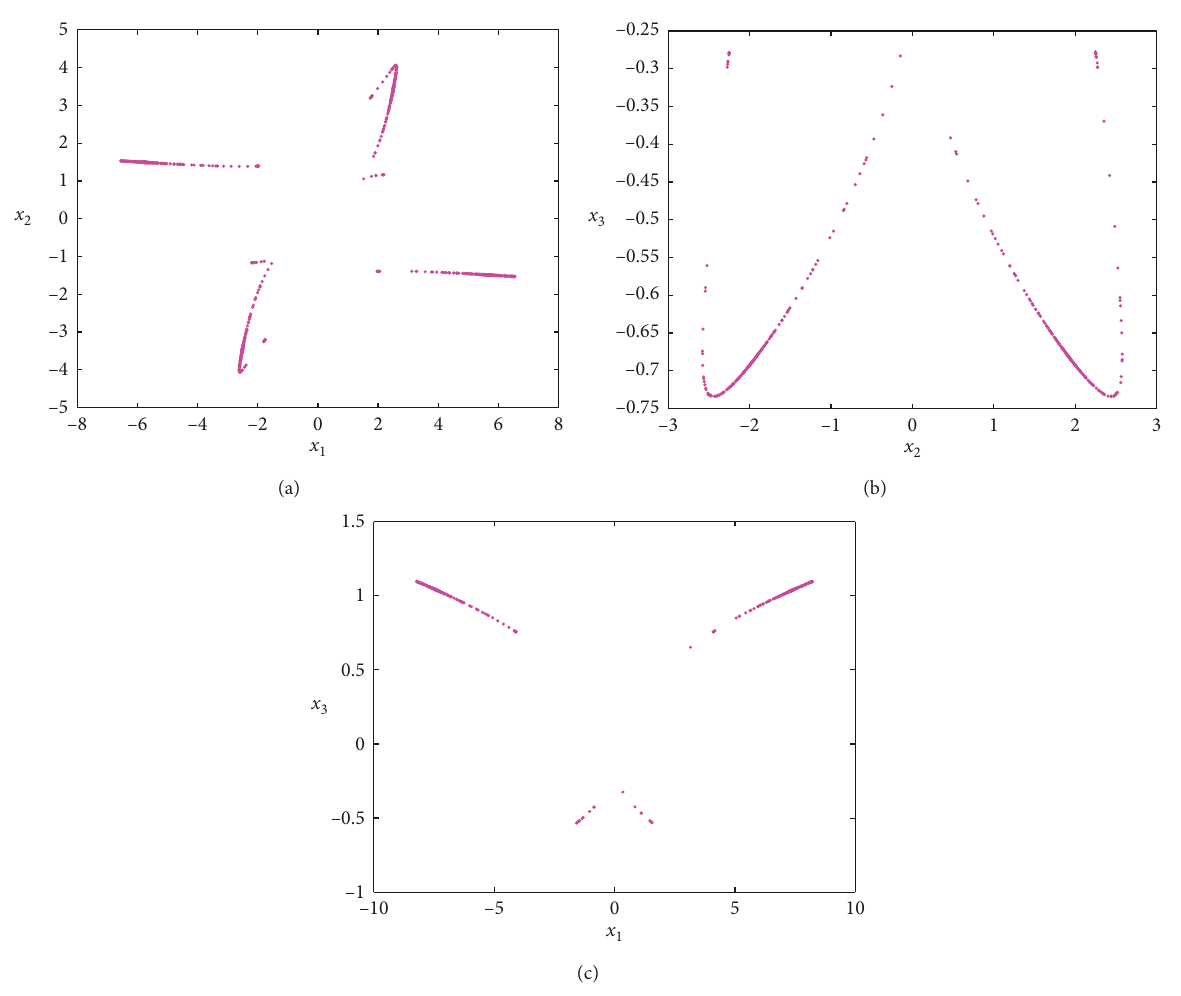
� 0, (b) x � 0, and (c) x 3 1